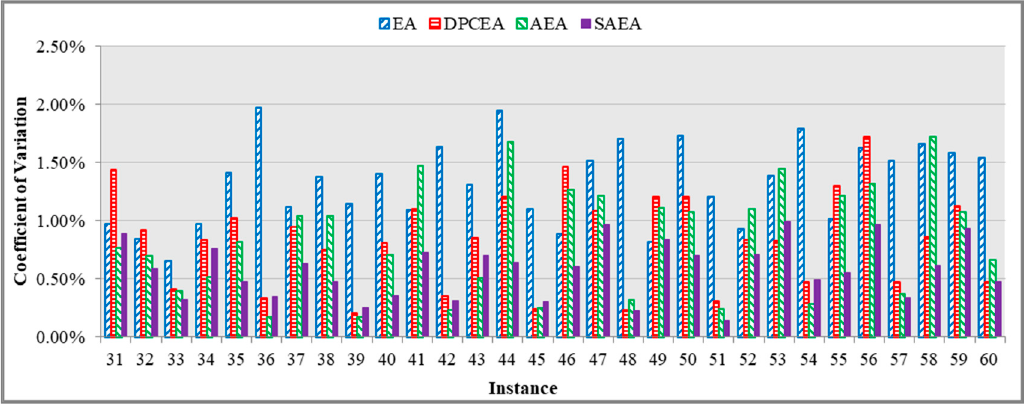
Figure 13. The objective function coefficient of variation values for the developed solution algorithms and large size problem